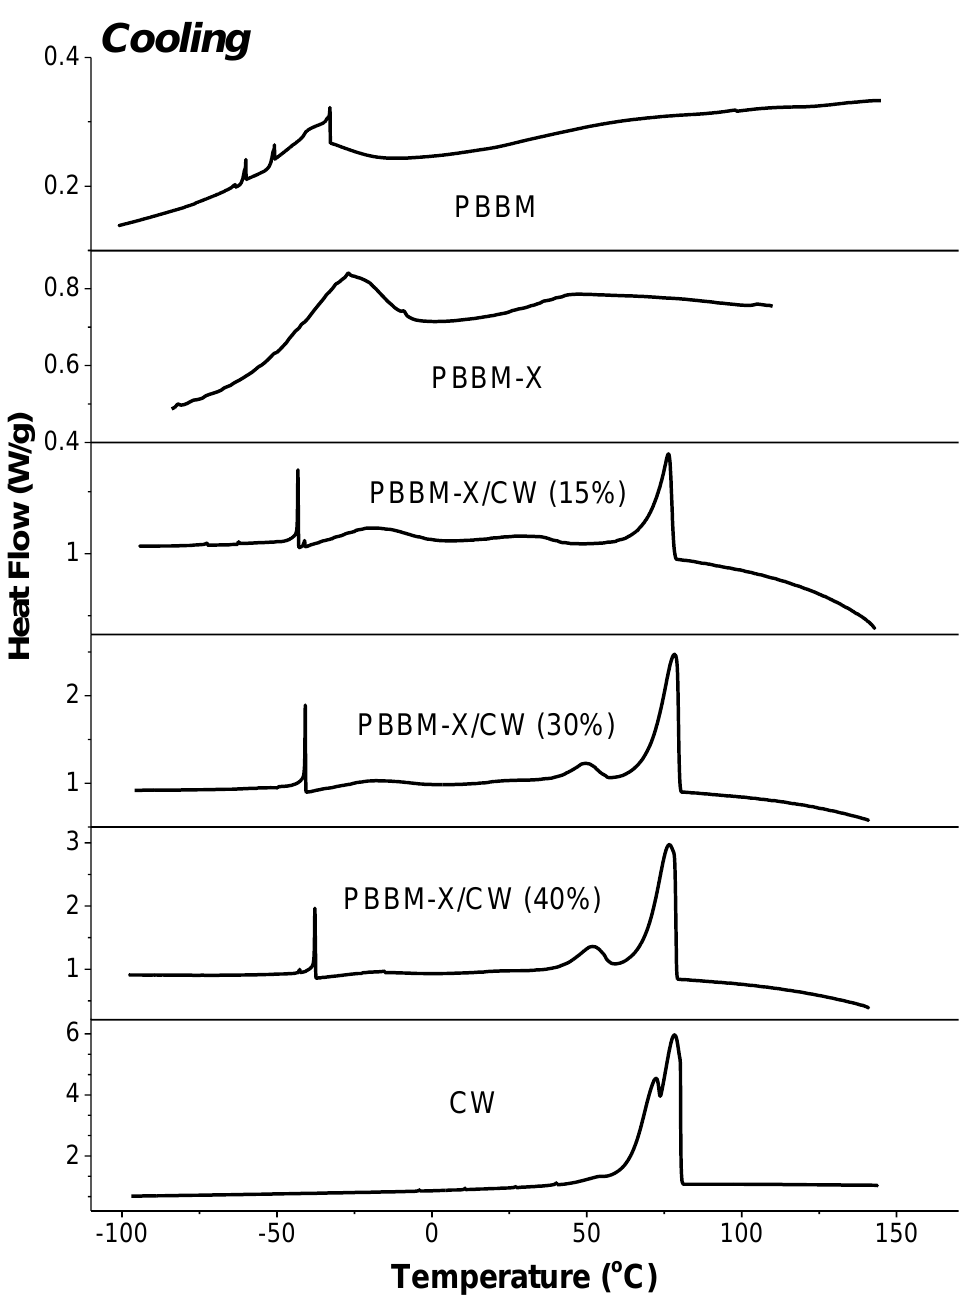
Figure 6. DCS cooling traces for the bioplastics. When 5 wt% of xylan grafted with BBM is incorporated into PBBM, the thermal transitions resemble the ones observed for PBBM (Figure 5). However, the PBBM-X transitions appeared to be somewhat shifted. The onset Tg for the side groups and the group’s Tm increased to ~ − 60 ◦ C and − 20 ◦ C, respectively. The main chain Tg, however, decreased to about 40 ◦ C. The obtained result indicated that the presence of about 40 wt% of xylan grafted with BBM macromolecules decreased the mobility of the alkyl side fragments but increased the mobility of the chains constituting the PBBM-X material. We also note that the glass transition for the main chain demonstrates the presence of secondary relaxations [37], which (as evident from the DSC traces) disappear on the controlled cooling.